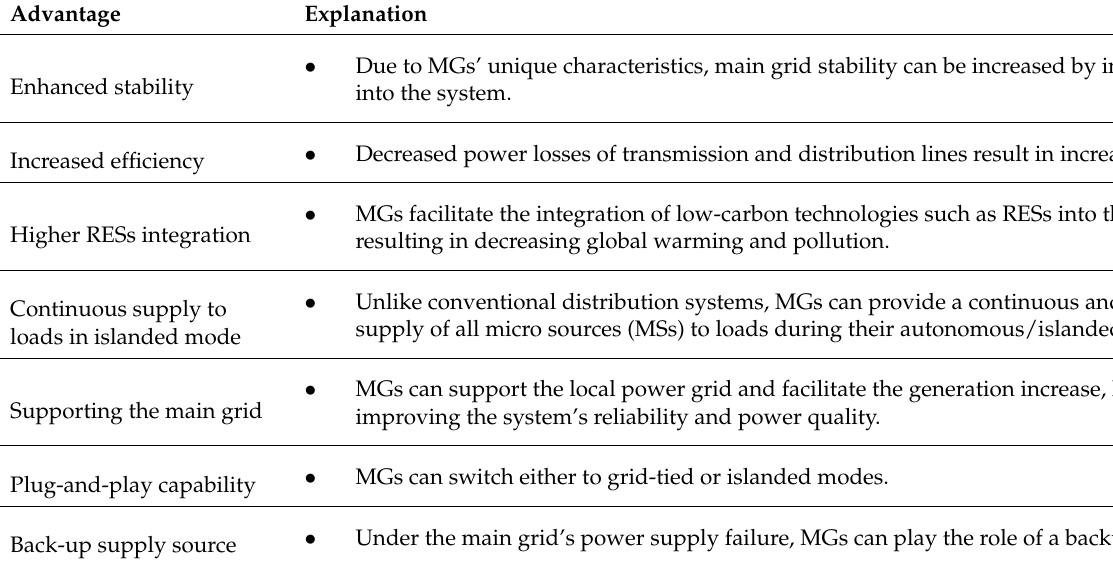
Table 5. Main advantages of MGs over conventional distribution